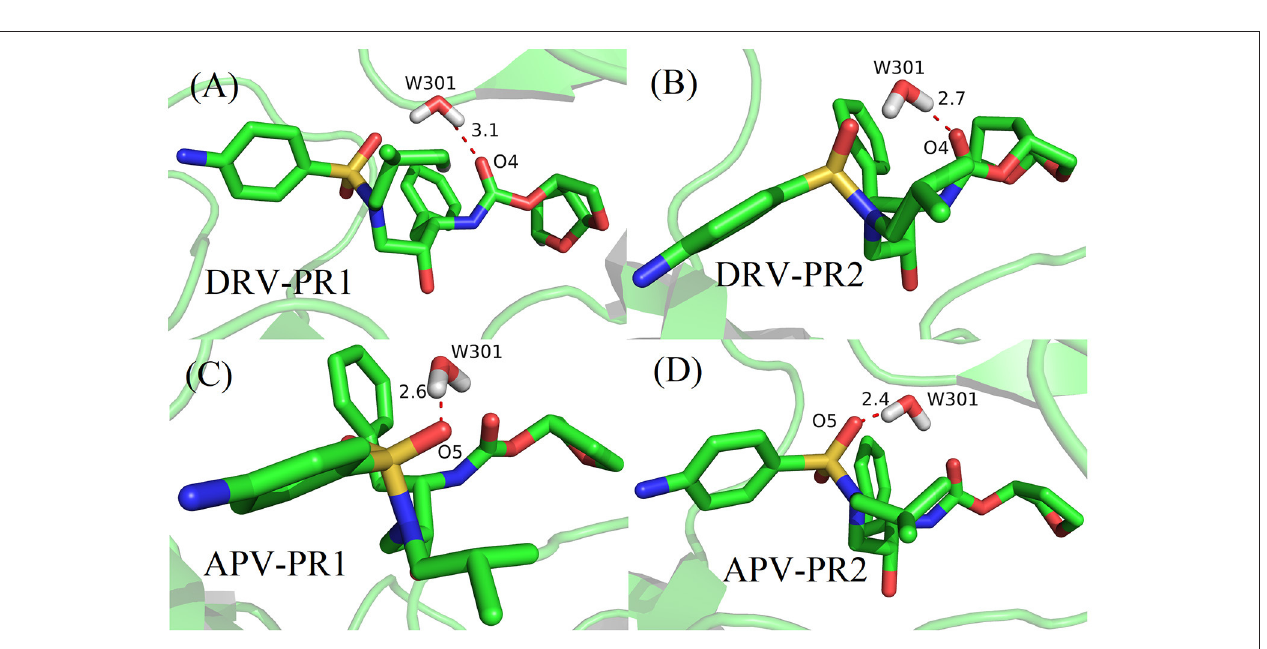
operating mode of binding pocket (Duan et al., 2015; Triki et al., 2018). As the active region of binding between protein